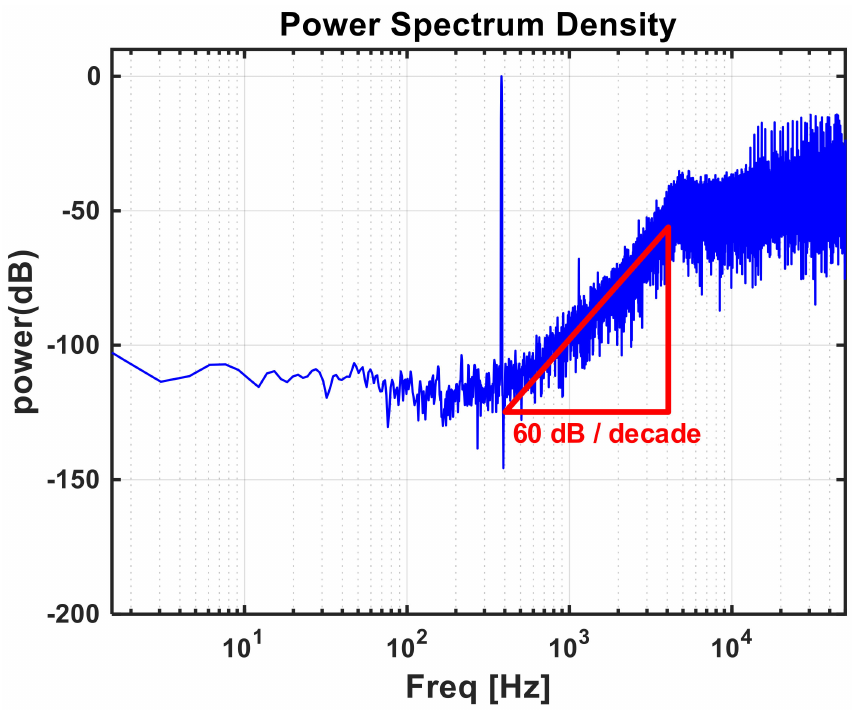
Figure 20. Power spectral density of third-order delta-sigma ADC output. The ADC, negative voltage supplier, TIA, and HEMT device introduced in the previ- ous section constitute the overall system, as shown in Figure 21. Stable and accurate gas detection is possible with this system by calibration through a digital controller.